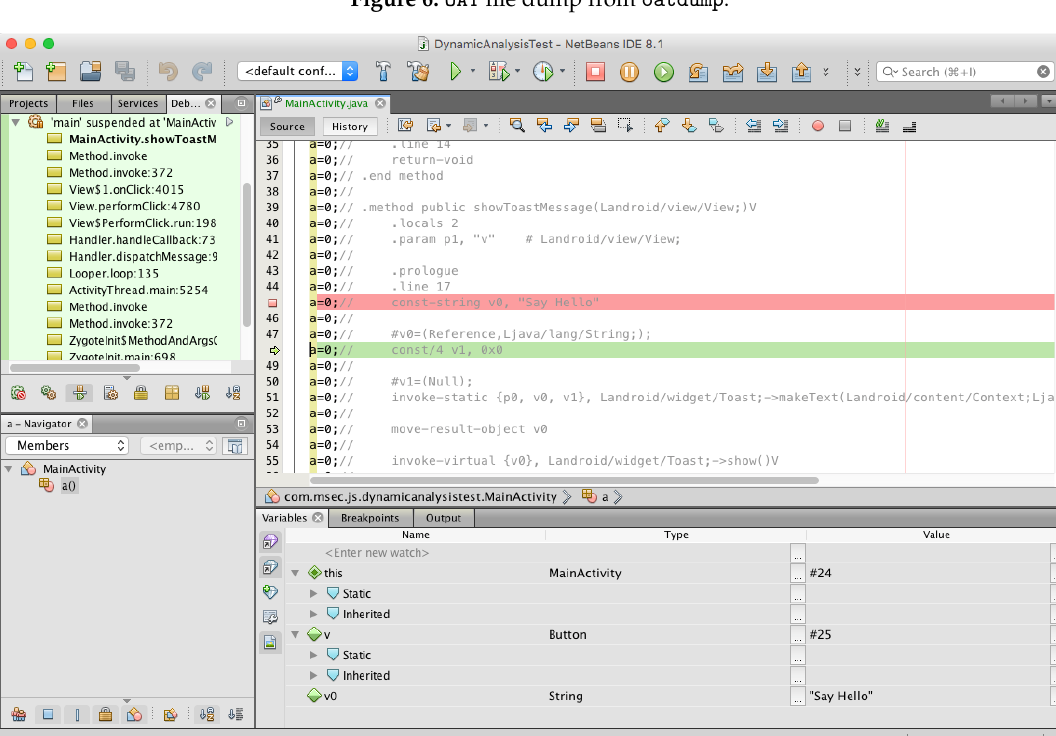
Figure 6. OAT file dump from oatdump .